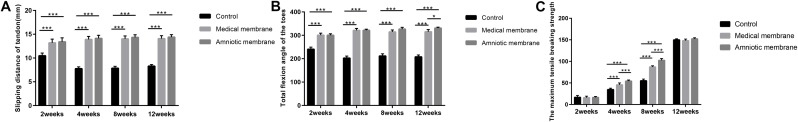
Comparison of biomechanical results at different time points after operation.The SNK method was used to compare the two groups, and the P < 0.05 indicated that the difference was statistically significant. (A) No significant difference was found in the slipping distance between the amniotic membrane group and the medical membrane group at each time point, which was higher than that of the control group (P < 0.05). (B) No significant difference was found in the angle of total flexion between the amniotic membrane group and the medical membrane group at each time point after the operation, which was higher than that of the control group (P < 0.05). (C) No significant difference was found in the maximum tensile breaking strength between the 2nd and 12th week after operation (P > 0.05). At the 4th and 8th week, the maximum tensile breaking strength of the amniotic membrane group and medical membrane group was higher than that of the control group (P < 0.05), whereas the amniotic membrane group was higher than that of the medical membrane group (P < 0.05).